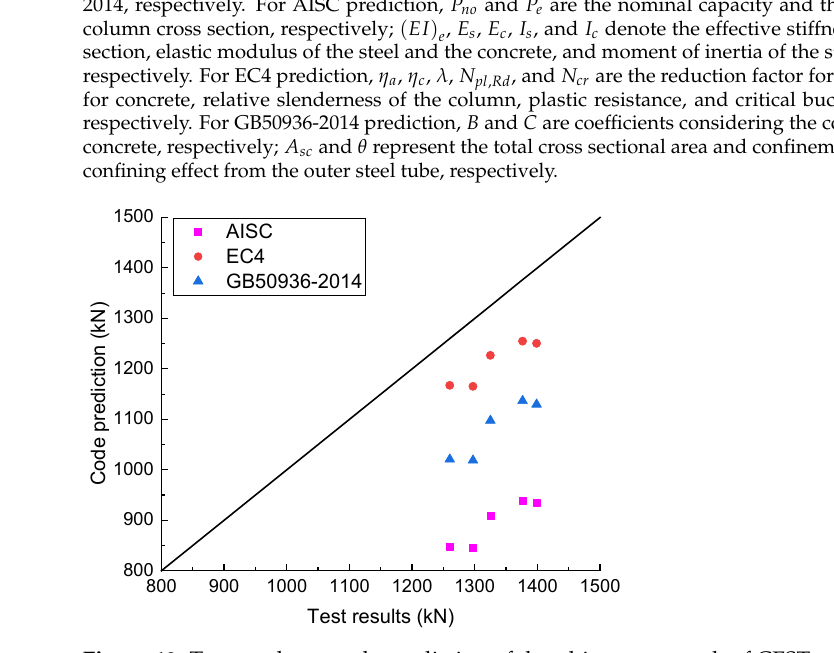
Figure 12. Test results vs code prediction of the ultimate strength of CFSTs.